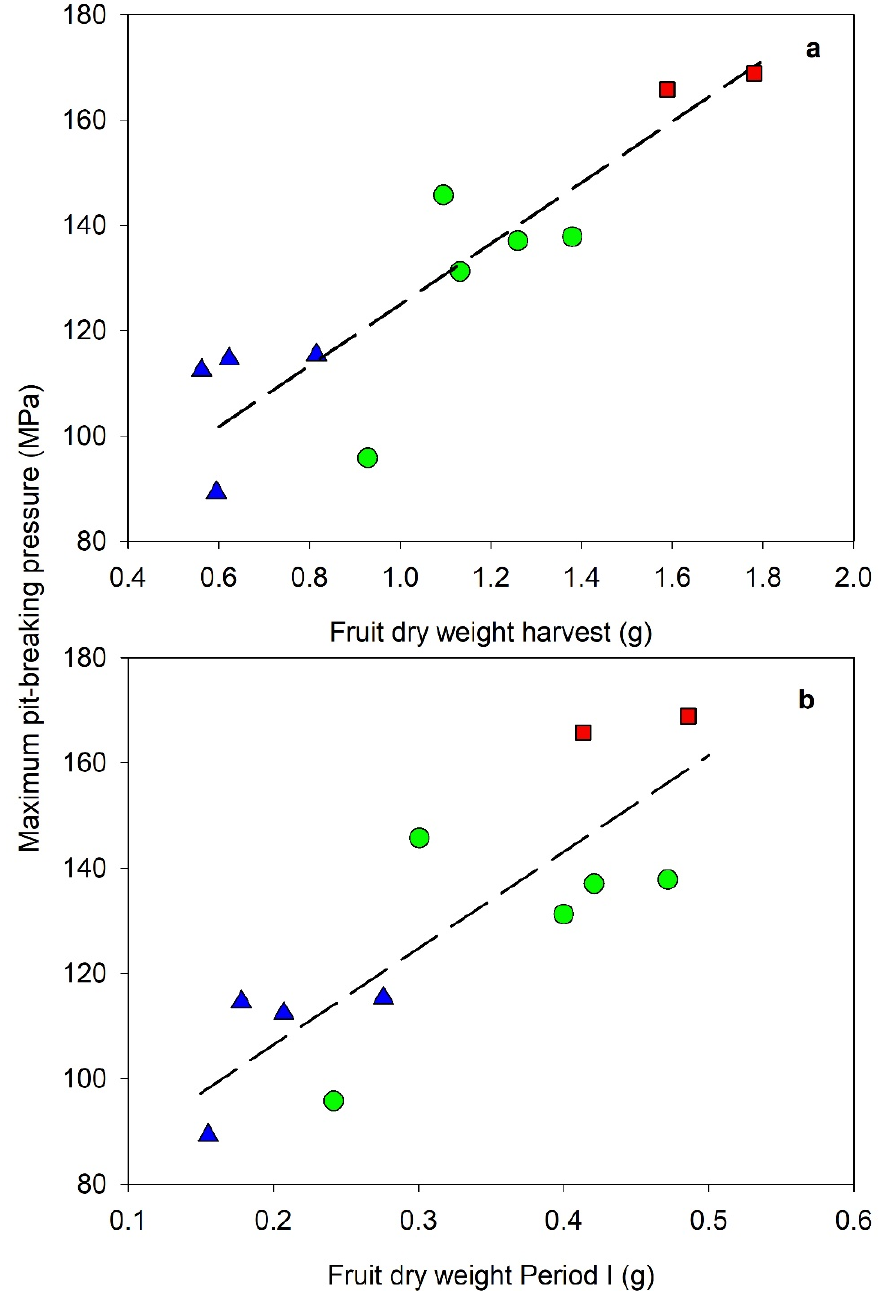
Figure 4. Relationship between fruit dry weight at harvest ( a ) and at the end of period I ( b ) vs. maximum pit-breaking pressure at harvest. Green circle, cv Cornicabra; Blue triangle, cv Arbequina; Red square, cv Manzanilla. Dashed lines represented the best fit with all data. ( a ) Pressure = 57.40 W + 67.43; N = 11; R 2 = 0.78, Error = 12.7 MPa; MSE = 161.3. ( b ) Pressure = 178.53 W1 + 70.89; N = 11; R 2 = 0.68, Error = 15.4 MPa; MSE = 236.6. Data are the average for each cultivar and season.